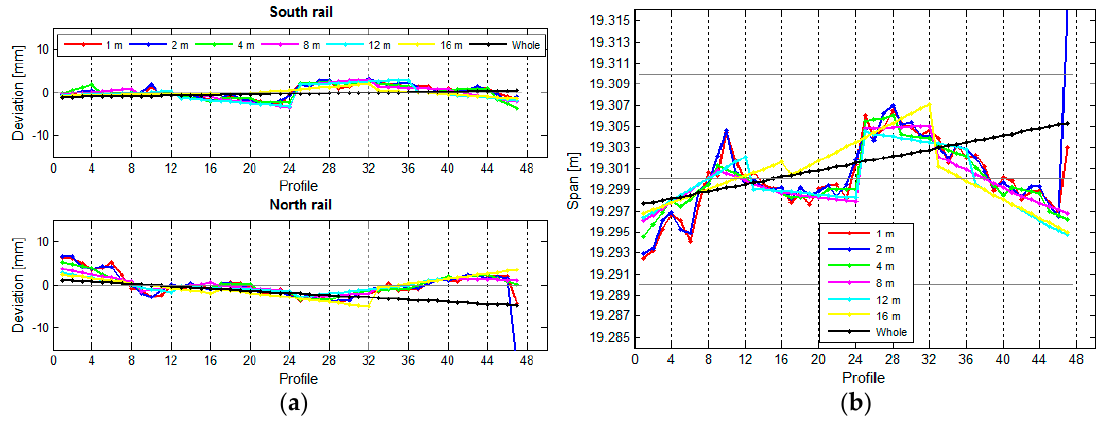
Figure 18. ( a ) The positional deviations and ( b ) the spans in relation to the segment length.